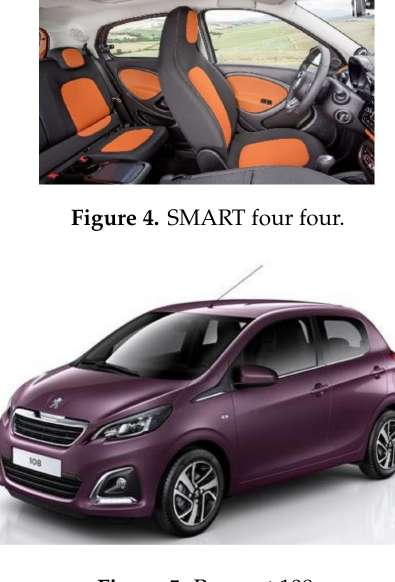
Figure 5. Peugeot